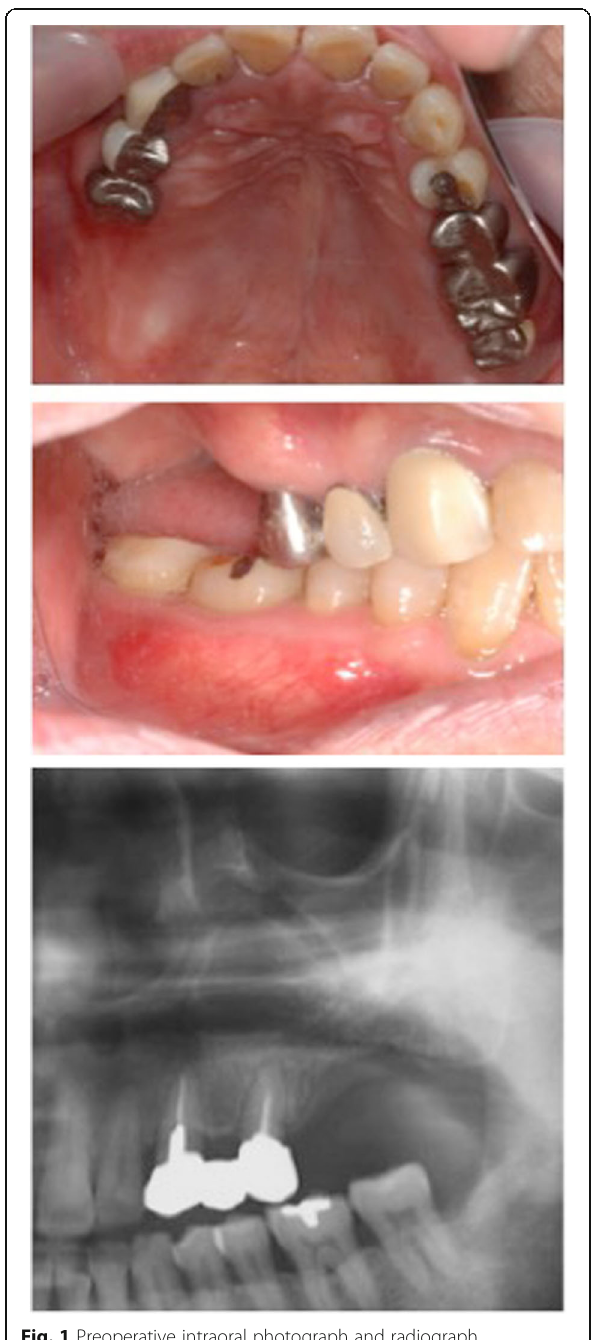
Fig. 1 Preoperative intraoral photograph and